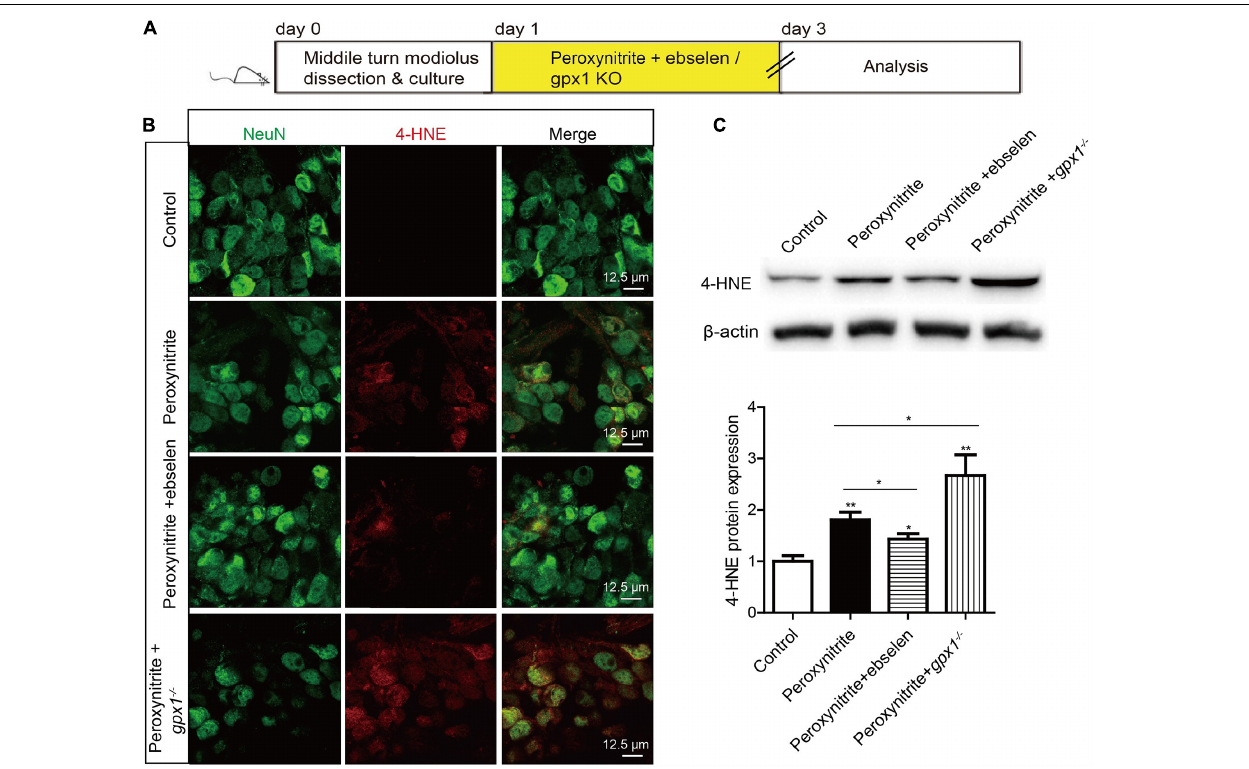
FIGURE 5 | Glutathione peroxidase attenuates peroxynitrite-induced oxidative stress in SGNs. (A) The cultured SGNs from P3 WT mice were incubated with 100 µ M peroxynitrite for 48 h with or without the pretreatment of 30 µ M ebselen for 1 h, or the SGNs from gpx1 − / − mice were exposed to 100 µ M peroxynitrite for 48 h. (B,C) Immunostaining and western blot results showed that obvious increased protein expression of 4-HNE was found in peroxynitrite treated SGNs, while it was significantly decreased in the peroxynitrite + ebselen group but further increased in the peroxynitrite + gpx1 − / − mice compared with the peroxynitrite-only group. Scale bar = 12.5 µ m. * p < 0.05, and ** p < 0.01, n = 3 for each